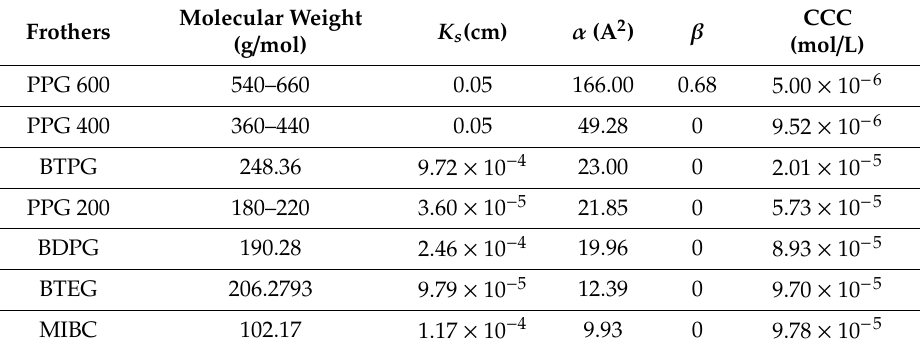
Table 3. Adsorption parameters and CCC values of the frothers investigated in this